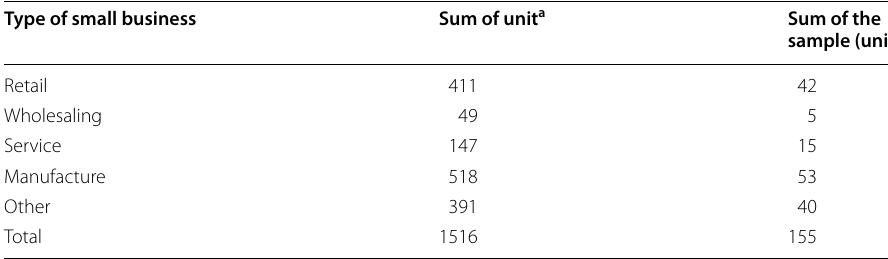
Table 1 Sample distribution on small